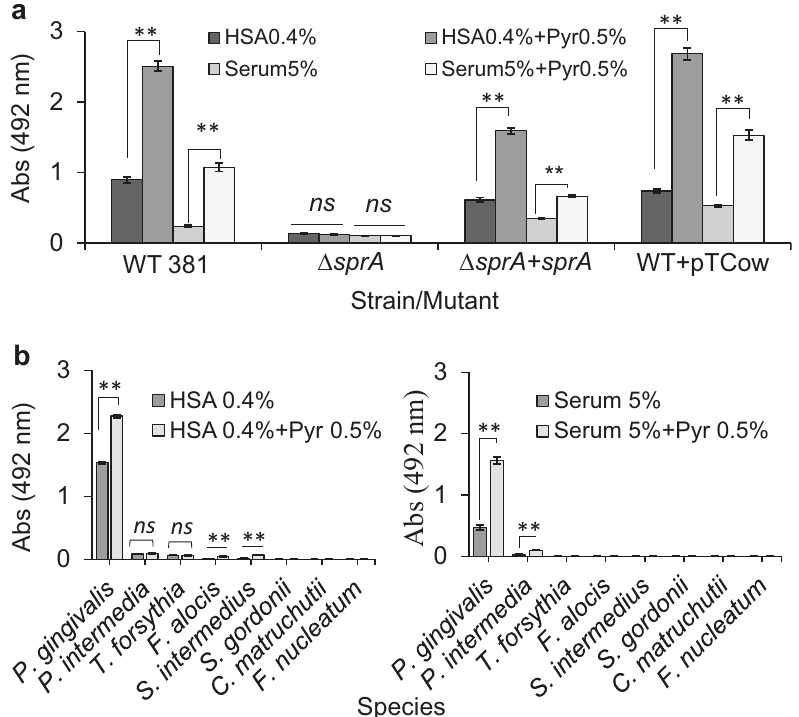
Fig. 2 Synergistic effects of the metabolism of pyruvate, lactate, and serum components on the bio fi lm formation of Δ sprA mutant, that lacks the essential translocon of the T9SS, and other oral pathogens. a Bio fi lm assay shows P. gingivalis Δ sprA mutant cannot ef fi ciently utilize serum components for bio fi lm development; this mutant is not responsive to pyruvate addition. But, upon in trans complementation with sprA , bio fi lm development was restored by the mutant, indicating there must be a metabolic coupling system to utilize protein components and pyruvate whose synergistic effect enhances metabolic fl ux towards bio fi lm development. b Mono-species bio fi lm assays show that among tested oral pathogens, only P. gingivalis effectively bene fi ts from the synergistic effects of concomitant utilization of pyruvate and serum components for enhancing bio fi lm. Statistically, P. intermedia , S. intermedius , and F. alocis positively responds to pyruvate addition but at very low levels. Graphs represent mean biomass of bio fi lms ± SE (two biological replicates, in each n = 3) at 48 h, as determined by safranin staining. Bio fi lm biomasses were normally distributed (Shapiro – Wilk test: p > 0.05), and thus analyzed using ANOVA test. Asterisks indicate pairs of signi fi cantly different values (post hoc Tukey ’ s HSD test: * p < 0.05; ** p < 0.01; ns not signi fi cant).